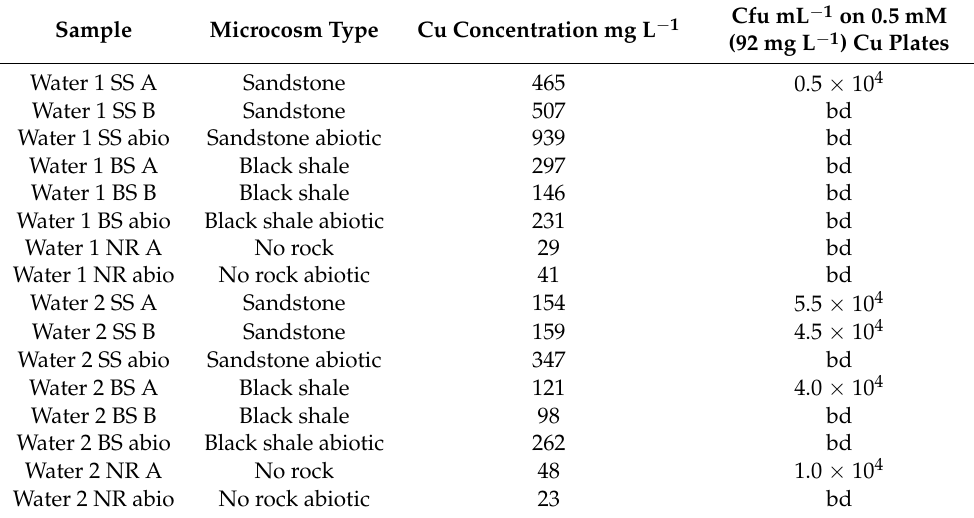
Table 2. Copper content and number of Cu tolerant culturable, heterotrophic bacteria mL − 1 micro- cosm water at the end of the incubation in the biotic (replicates A and B) and abiotic microcosms. Note that no rock microcosms are represented by single microcosms. bd–below detection limit (<10 3 mL − 1 ).